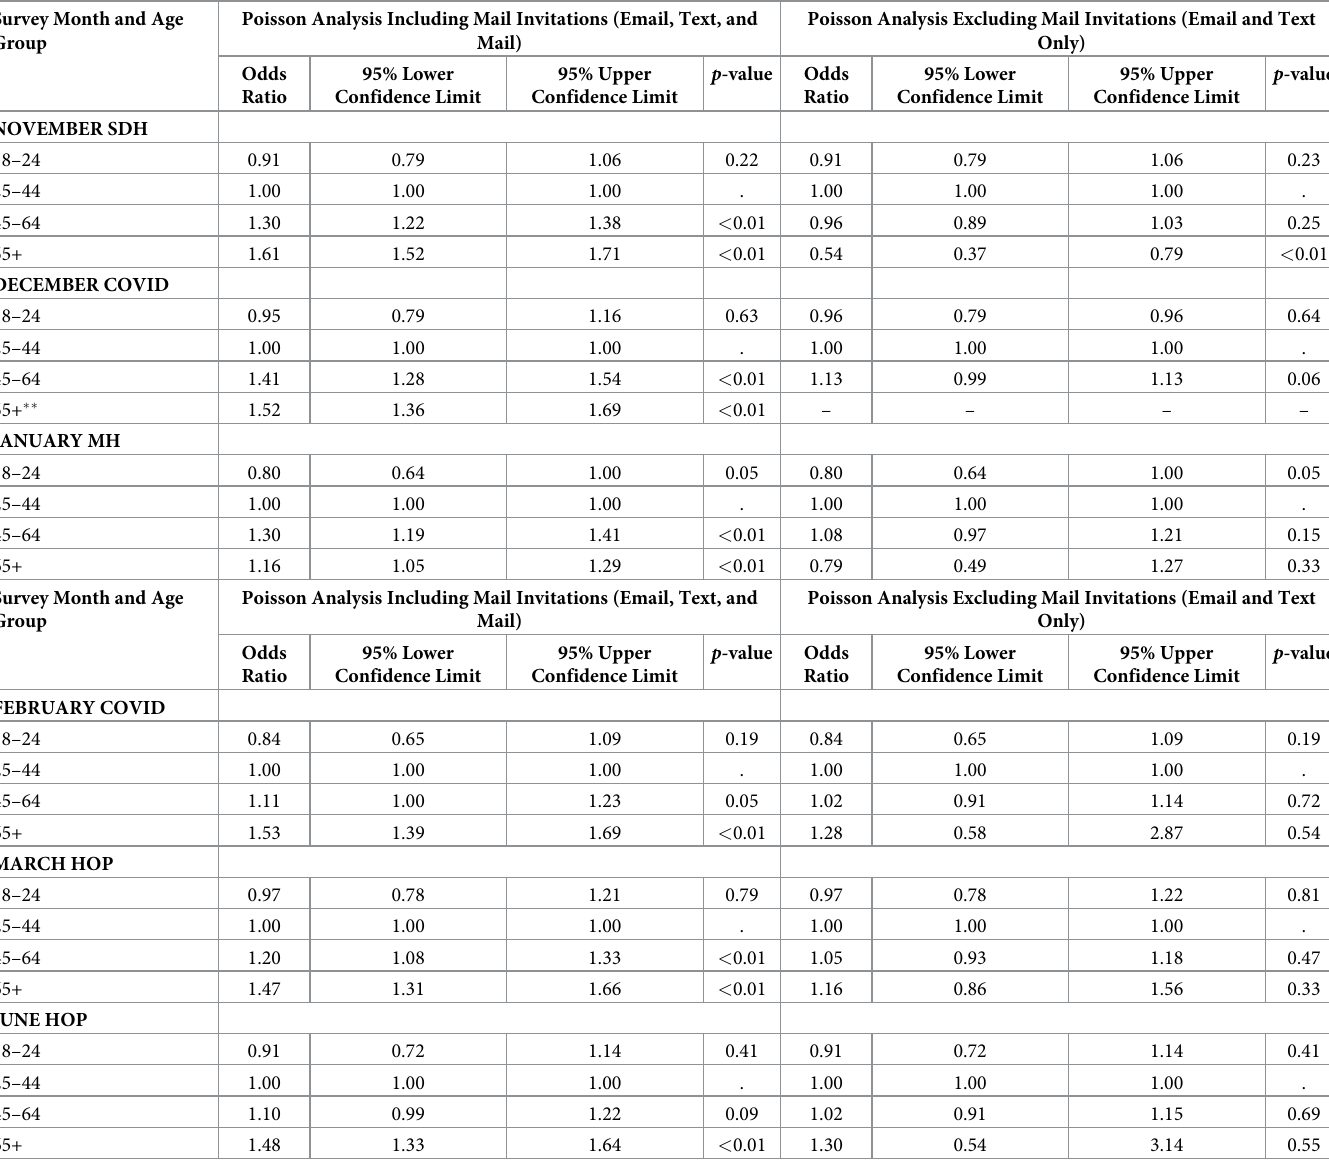
Table 9. Poisson regression table of age with number of invitations received before participating in a survey (including and excluding mail